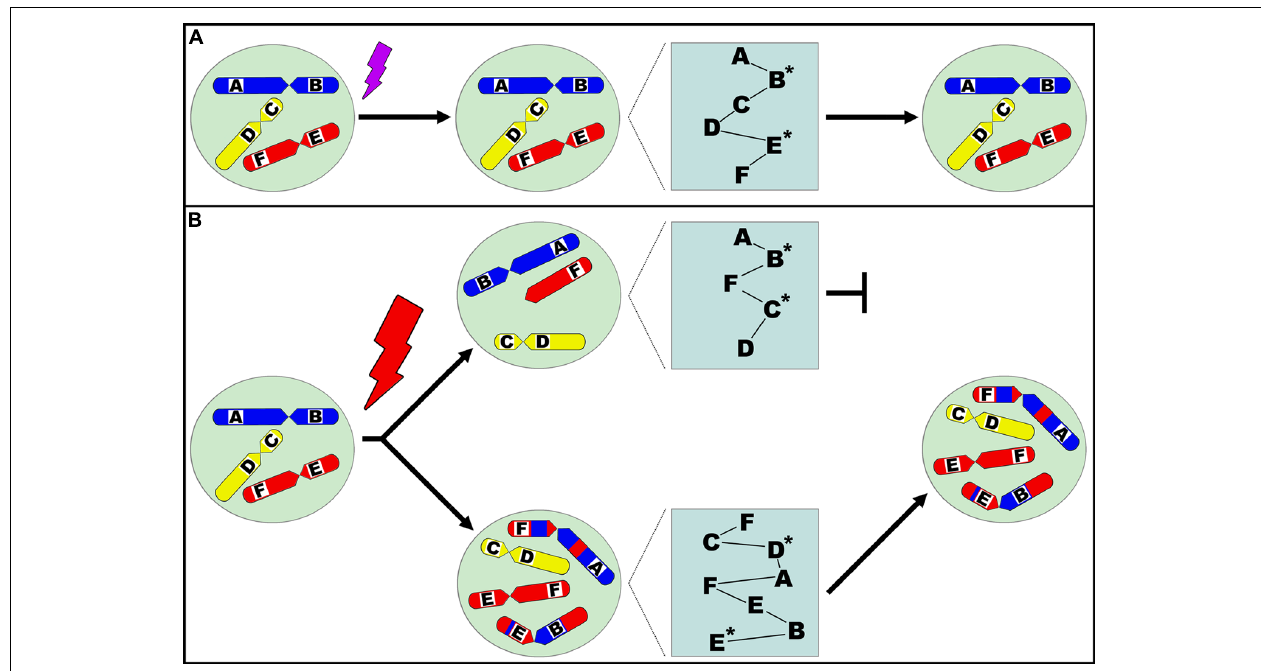
this results in genome topology alteration represented by numerical aberrations (e.g., aneuploidy) and/or structural aberrations (e.g., translocations).This directly affects the physical three-dimensional relationship between genes and changes the overall genetic network structure, resulting in drastic systemic changes beyond the influence of genetic and/or epigenetic alterations that may concurrently occur. As a consequence, the corresponding protein network changes are shown by altered relationships between proteins.These new genomic systems then undergo evolutionary selection, and those that are stochastically selected upon may clonally expand and dominate the cell population.